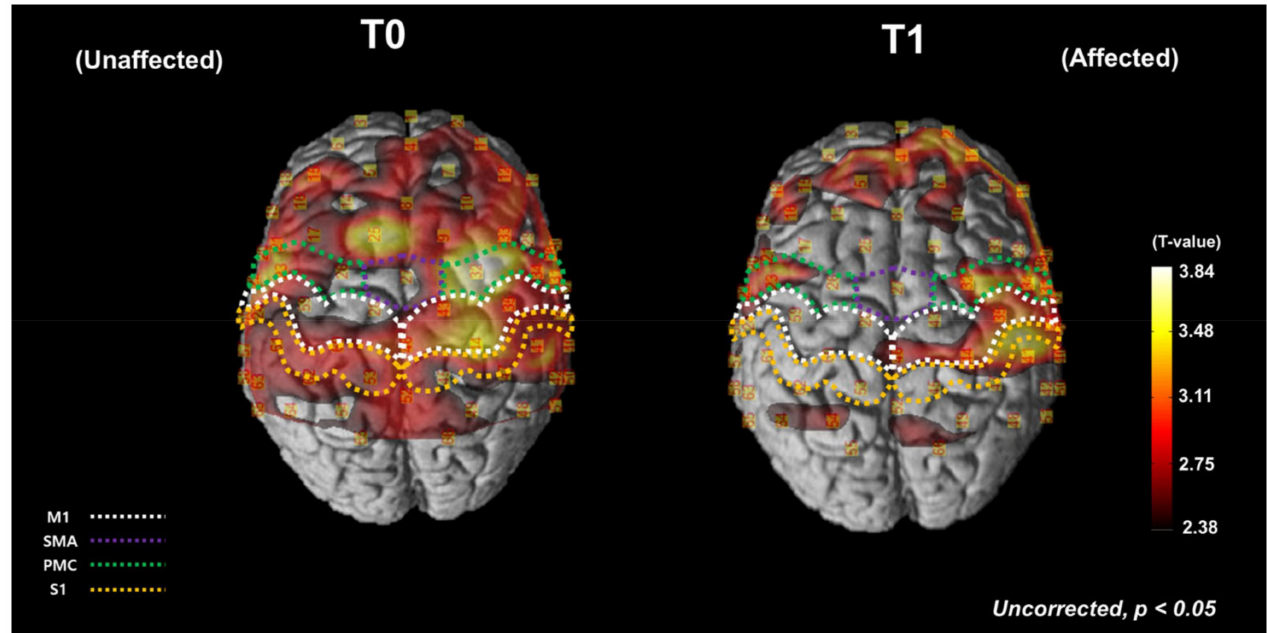
Figure 2. Average cortical activation maps, as analyzed using the NIRS-SPM software during the FTT with the affected hand before and after HD-tDCS intervention. The white dotted areas indicate the MThe green dotted areas indicate the SMA. The purple dotted areas indicate the PMC. The orange dotted areas indicate the SAt T0, the cortical oxyHb concentration increased during the FTT in both the affected and unaffected hemispheres. At T1, the overall cortical activation was decreased and most of the activation was shifted to the affected hemisphere. FTT, finger tapping task; T0, before the intervention; T1, after the intervention; M1, primary motor cortex; SMA, supplementary motor area; PMC, premotor cortex; S1, primary somatosensory cortex; oxyHb,